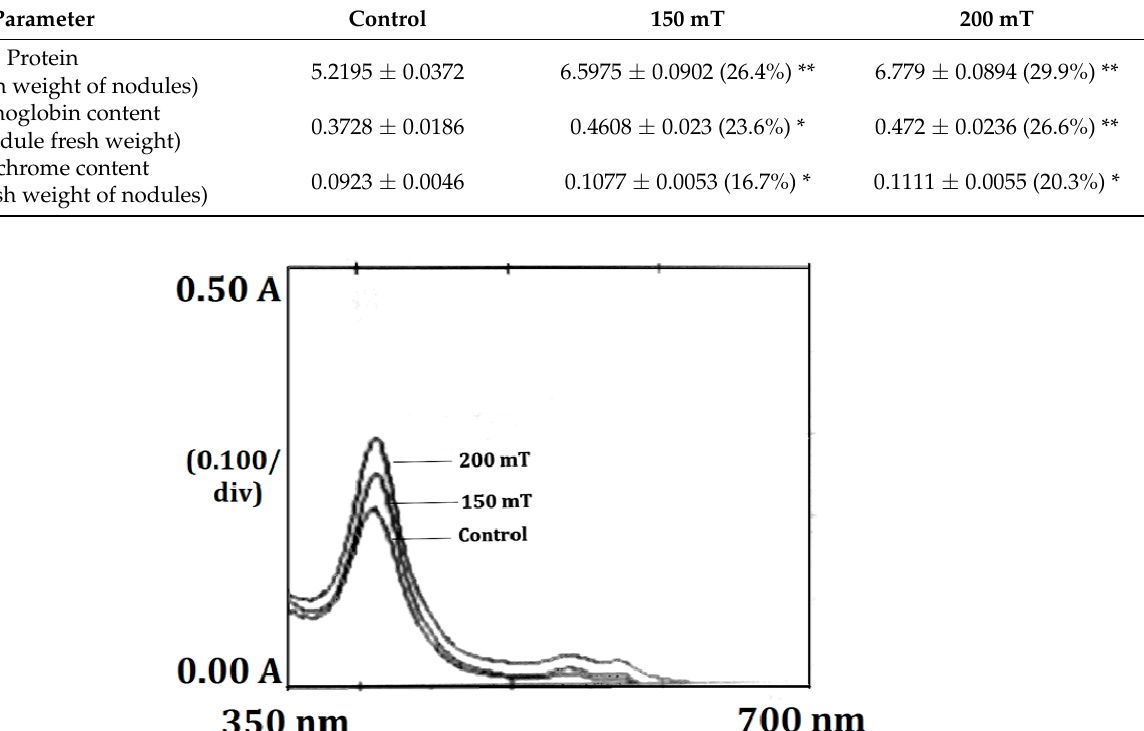
Table 2. Total protein, leghemoglobin and hemechrome content of the root nodules of soybean var. JS-335 on 45th DAE. Values in parenthesis show maximum percentage increase as compared to control. ** and * indicate significance at p < 0.01 and 0.05, respectively, compared to control.